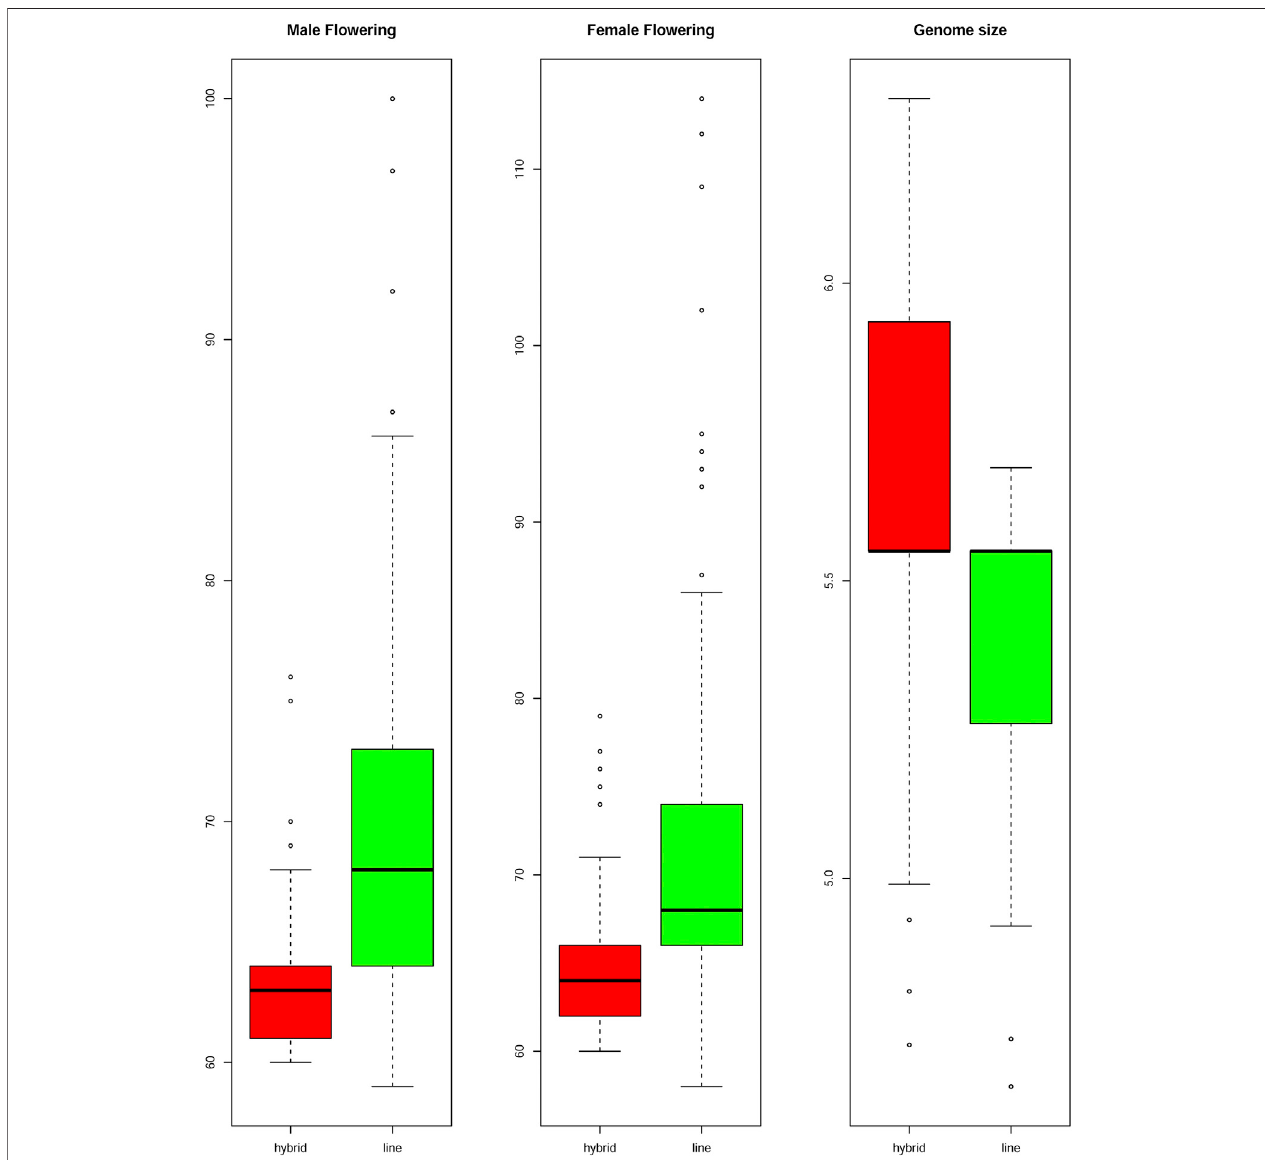
FIGURE3 | Flowering time and Genome Size ofthe hybrid and inbred lines. Boxplotscompare mean values between male and female fl owering time and genome sizeforinbredlines andhybrids.The fl oweringtimeisshowed indaysto fl oweringand thegenomesizeinpicograms. Theboxesindicatethe fi rstquartile(lowerline), the second quartile or mean (central line), and the third quartile (upper line). Additionally, the whiskers represent the standard deviation with the dots as the